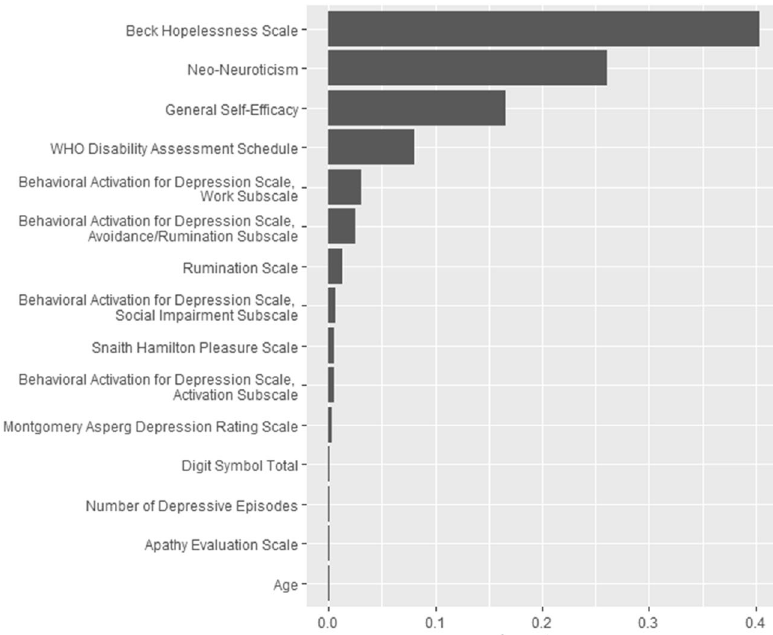
Fig. 2 Variable importance in predicting membership to suicidal ideation trajectories in older adults with major depression ( N = 249) during 9 weeks of treatment with “ Engage ” or problem-solving therapy estimated by gradient-boosted machine. Predictors are ordered from top to bottom in order of importance in the Gradient-Boosted Machine. The horizontal axis represents the variable importance measure in the Gradient-Boosted Machine that quanti fi es the improvement in prediction accuracy due to a